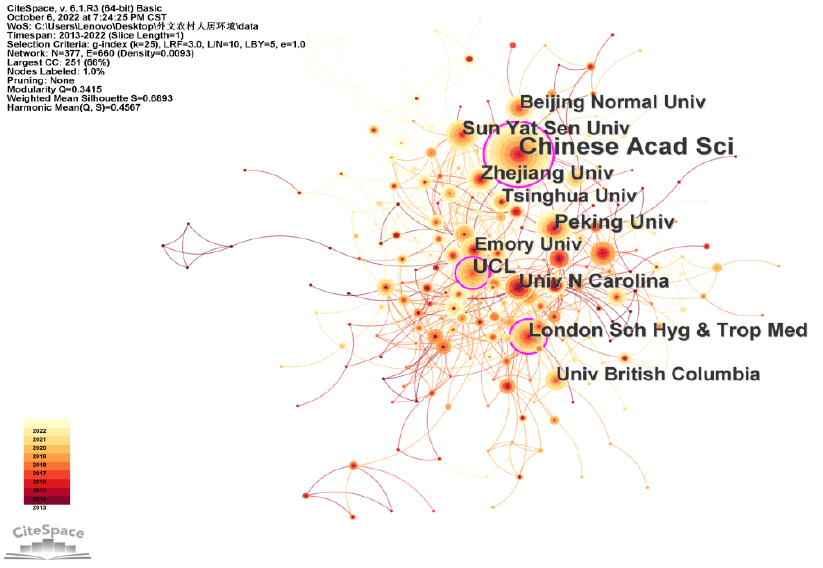
Figure 13. Institutional cooperation network of rural human settlement environment research.